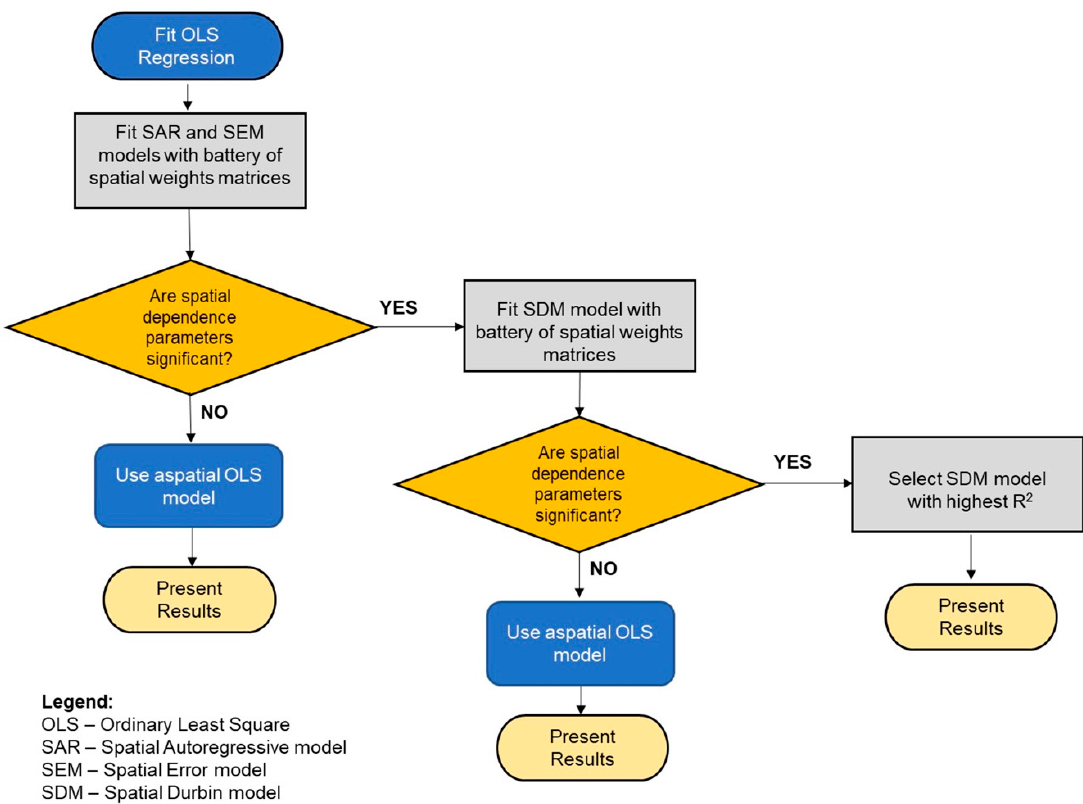
Figure 2. Analytical Approach.